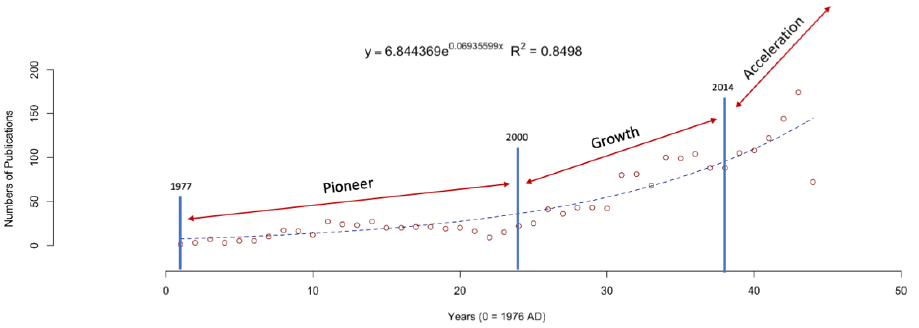
Figure 2. Publication dynamics showing pioneering, growth, and acceleration phases. Table 1. Fitted exponential model parameters. Parameters